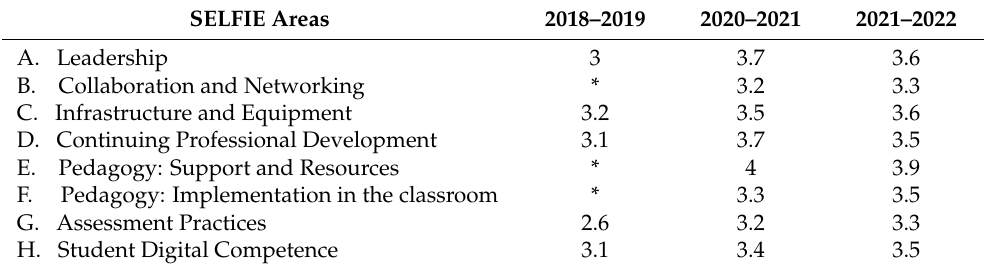
Table 10. Average score of the answers of all the participants for each one of the areas of